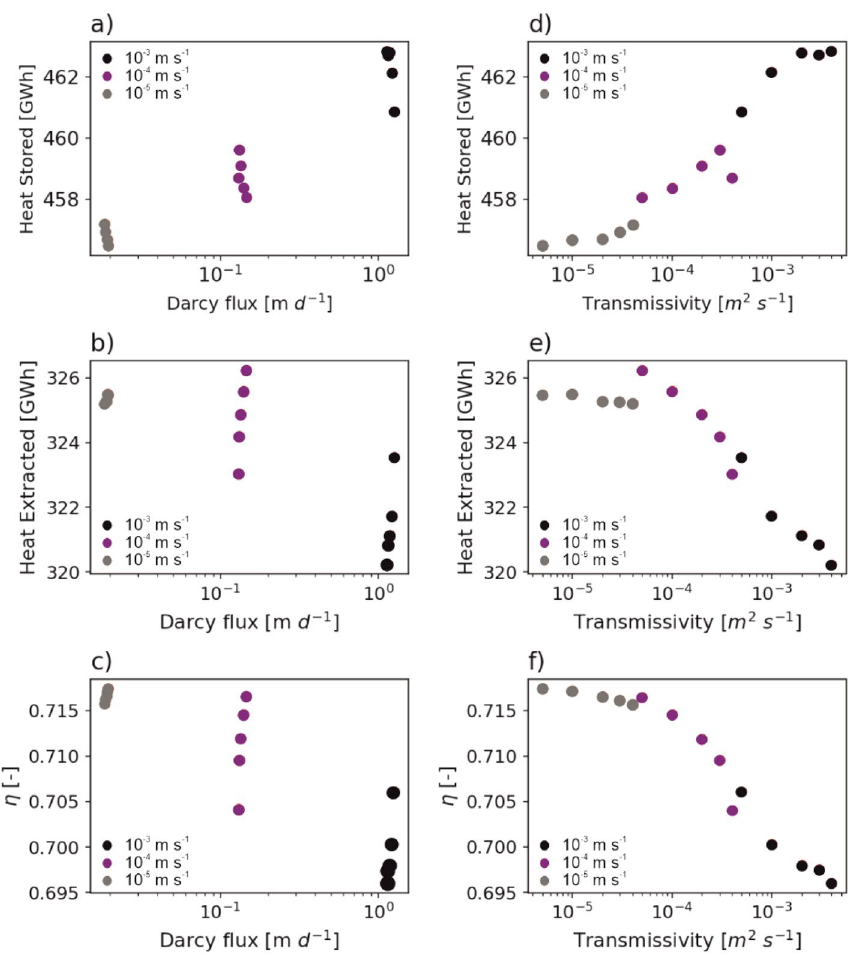
Fig. 12 Influence of the Darcy flux ( a – c ) and transmissivity ( d – f ) on the amount of heat stored, the heat extracted and the storage efficiency